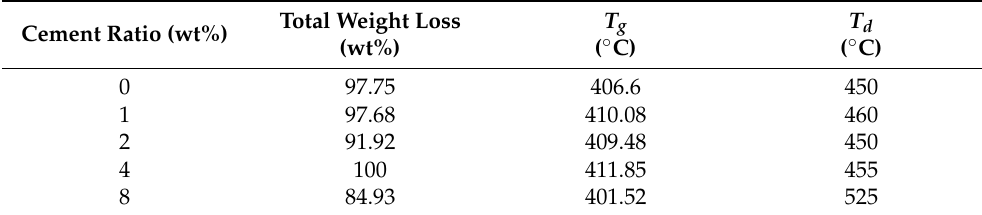
Table 2. Total weight loss at 1000 ◦ C, glass transition temperature ( T g ), and decomposition temperature ( T d ) for acrylic polymer/cement nanocomposites.